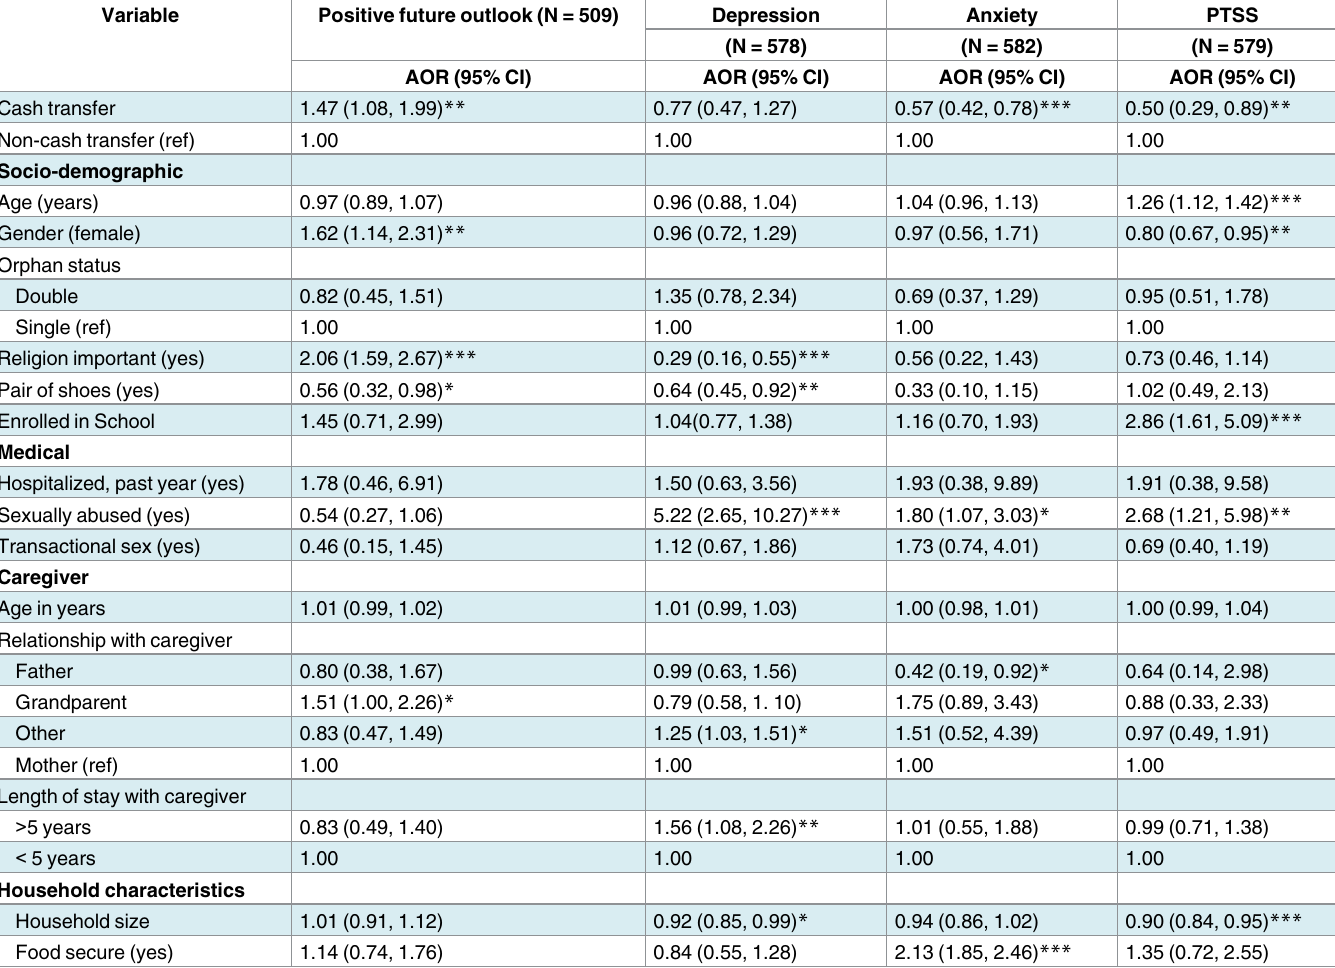
Table 3. Adjusted odds ratios (AOR) and 95% confidence intervals for associations between psychological outcomes and cash transfer among OVA